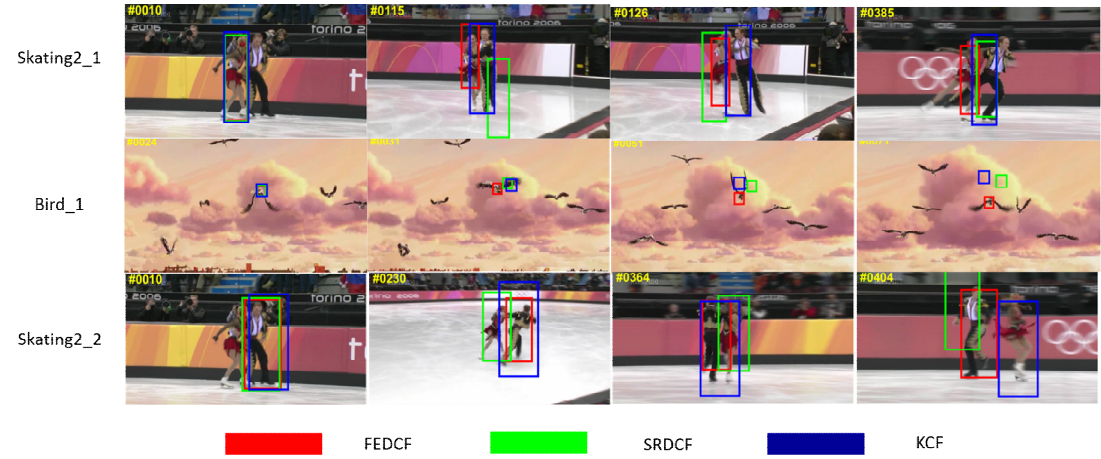
Figure 7. The screenshots from Skating_1 , Bird 1 and Skating_2 , where the targets are the female skater, bird at the screen center and the male skater, respectively. The target results of FEDCF, SRDCF and KCF are respectively highlighted with red, green and blue bounding boxes.